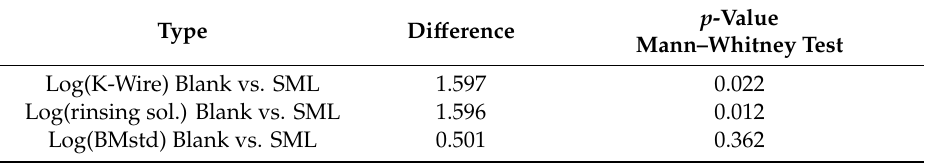
Table 3. Results from the Mann–Whitney test of Blank and SML items after explantation.